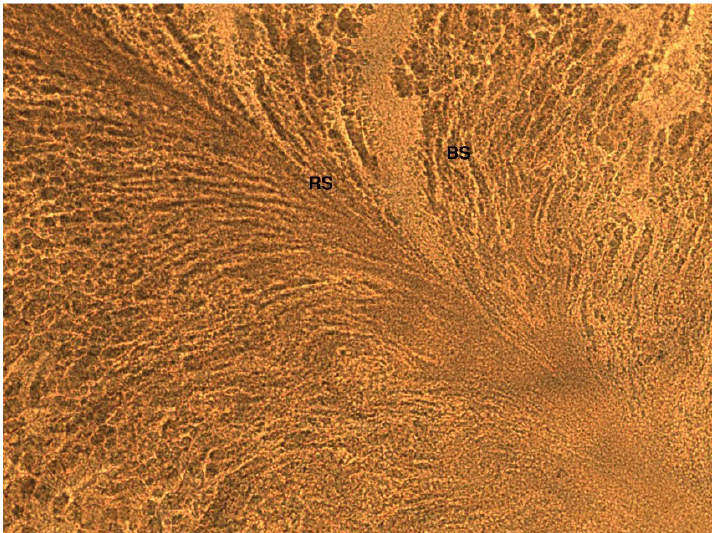
Figure 3. Digital image (400X) of microscopic analysis in bright field representing the interaction of Bacillus subtilis against Ralstonia spp. BS represents Bacillus subtilis species (see Table 1), and RS represents Ralstonia spp . Both BS and RS were streaked near to each other to see the interaction between two species. BS has completely overgrown the RS streak on the CPG agar plate, which suggests that there has been an interaction between RS and BS and BS is dominant over RS.